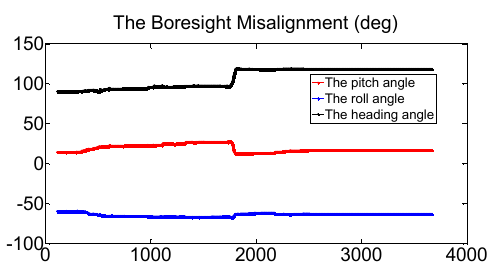
Figure 14. The trajectory of INS/NHC solution is smoothed, but meters because many turnings and bump in the